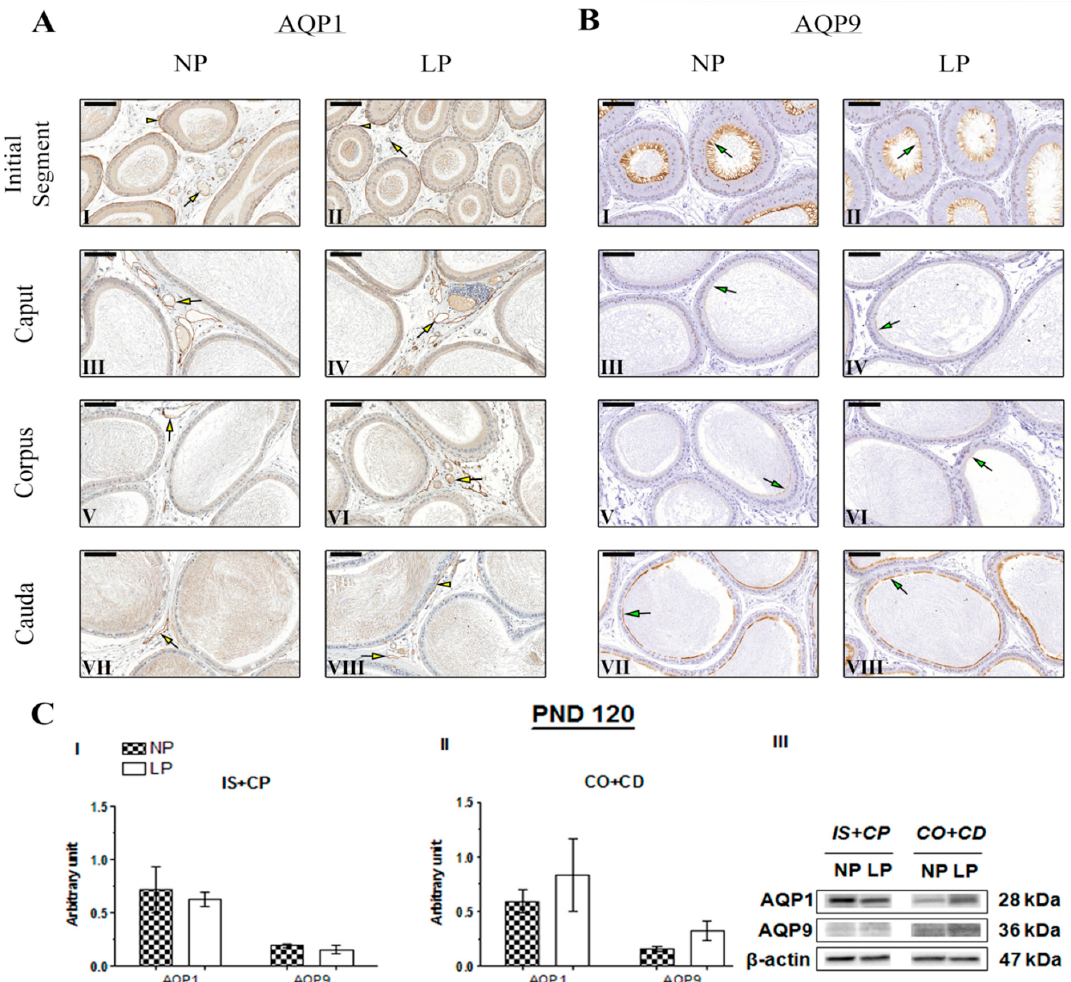
Figure 6. Expression and immunolocalization of AQP1 and AQP9 in the epididymis of 120-day-old animals. ( A ) Immunoreactivity for AQP1 in endothelial cells of vascular channels in the initial segment ( I and II ), caput ( III and IV ), corpus ( V and VI ), and cauda ( VII and VIII ) of NP and LP animals (yellow arrows). AQP1 immunostaining was also observed in the peritubular muscle cells of the initial segment in NP and LP animals ( I and II ) and in the peritubular muscle cells of the cauda in LP animals ( VIII ) (yellow arrowheads). ( B ) Immunoreactivity for AQP9 in the stereocilia of epididymis principal cells in the initial segment ( I and II ), caput ( III and IV ), corpus ( V and VI ), and cauda ( VII and VIII ) of NP and LP animals (green arrows). Bar = 50 µ m. ( C ) Extracts obtained from individual animals were used for a densitometry analysis of the levels of the proteins in the initial segment plus caput ( I ) and corpus plus cauda ( II ) following normalization to the housekeeping protein β -actin. Representative blots showing levels of the AQP1, AQP9, and β -actin proteins ( III , right panel). Data are presented as means ± S.E.M. and were analyzed using the Mann-Whitney test. 2.5. The Maternal Low ‐ Protein Diet Changes AQP1 and AQP9 Expression in the Epididymis of the Offspring Maternal protein restriction during gestation and lactation decreased AQP1 and AQP9 expression in the IS+CP and increased the levels of these proteins in CO+CD epididymis at all ages analyzed. However, these results were only significant for AQP9 in the IS+CP (0.14 ‐ fold decrease compared with the NP group) and CO+CP (2.94 ‐ fold increase compared with the NP group) and for AQP1 in the CO+CD (1.6 ‐ fold increase compared with the NP group) on PND 44. At this age, AQP1